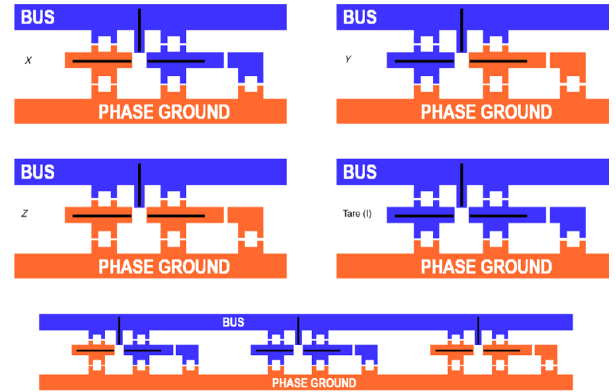
FIG. 13. Top four panels: Qubit design showing measurement configurations for X , Y , Z , and Tare ( I ) measurements of a qubit. Bottom panel: Portion of a RAMM in a configuration measuring X ⊗ I ⊗ Z